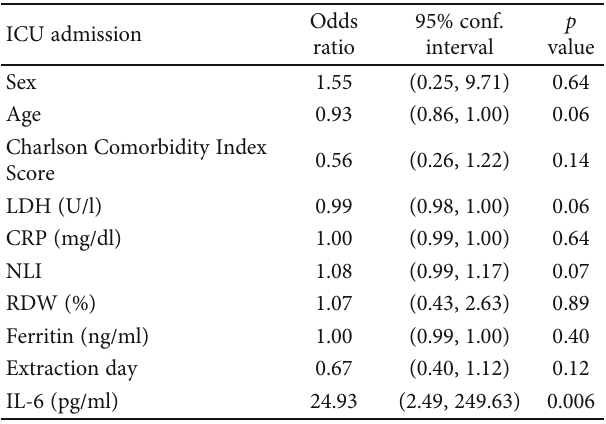
Table 4: Odds ratio (OR) for UCI admission adjusted by age, sex, Charlson Comorbidity Index Score, and main analytical values in a multivariate model.